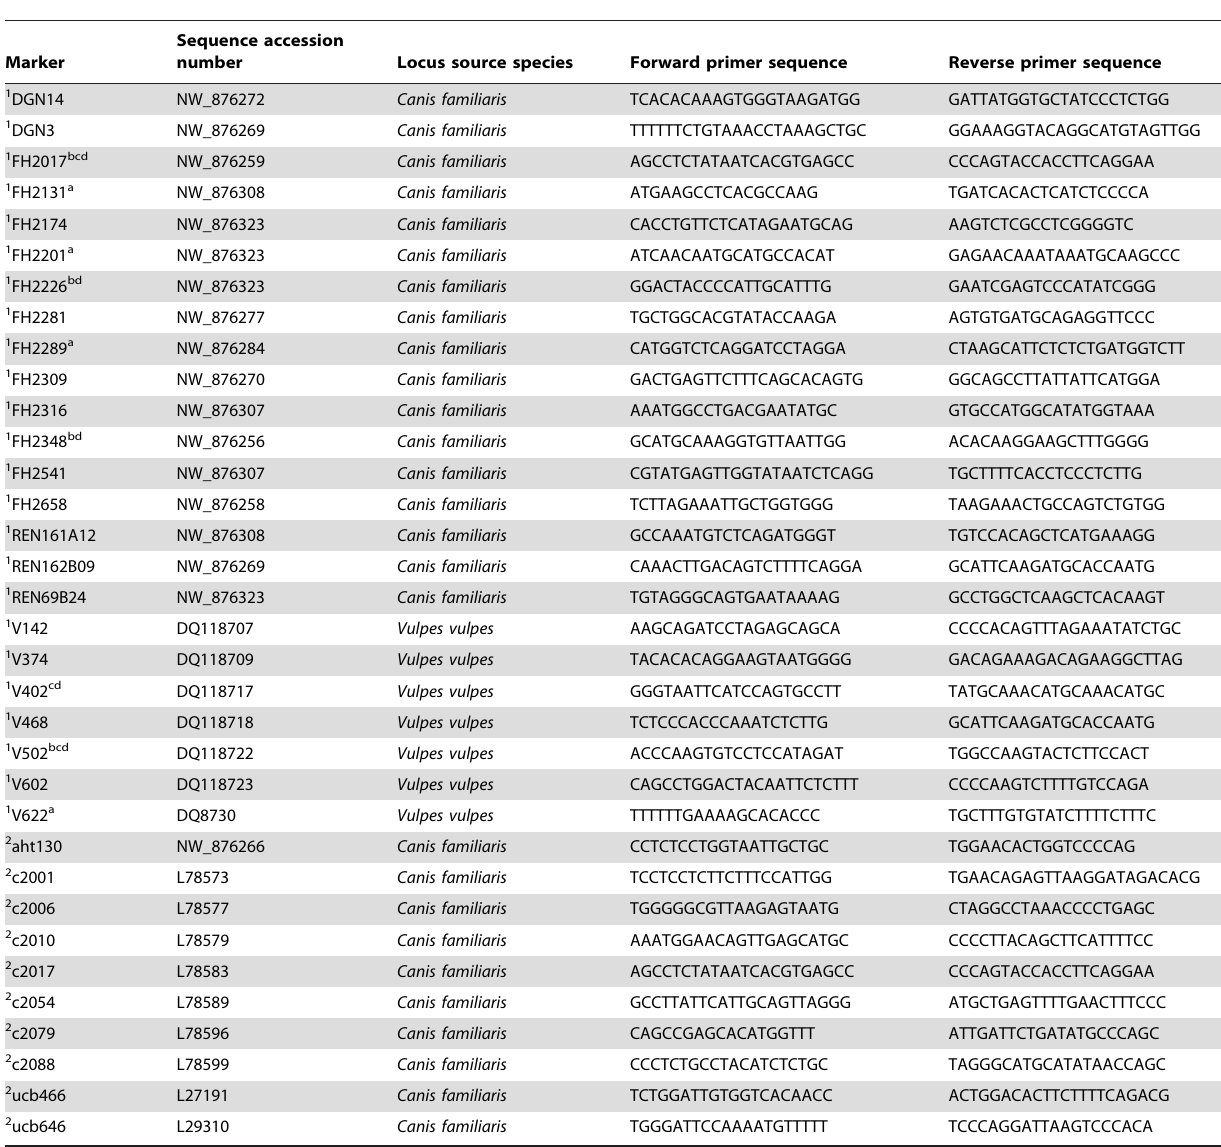
Table 1. Details of microsatellite markers used to genotype Bristol’s fox population and markers rejected for genotyping.